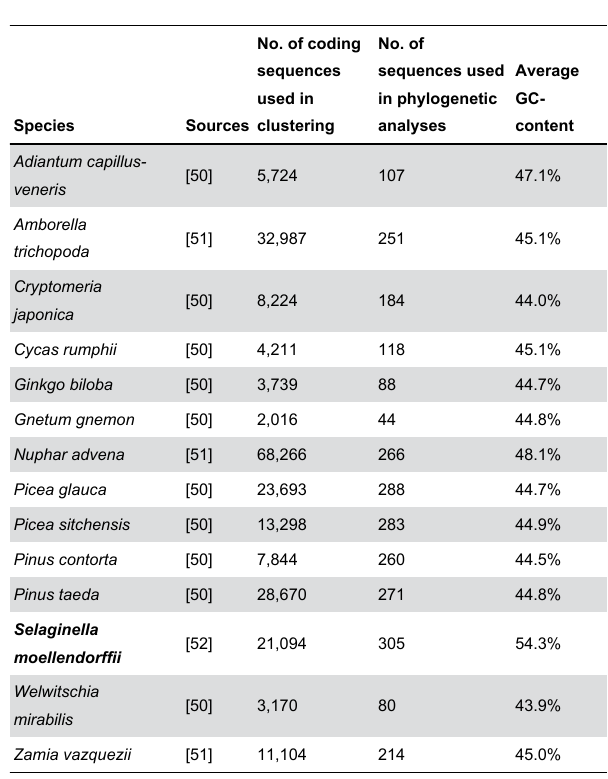
Table 1. Data sources of nuclear gene sequences included in our phylogenetic